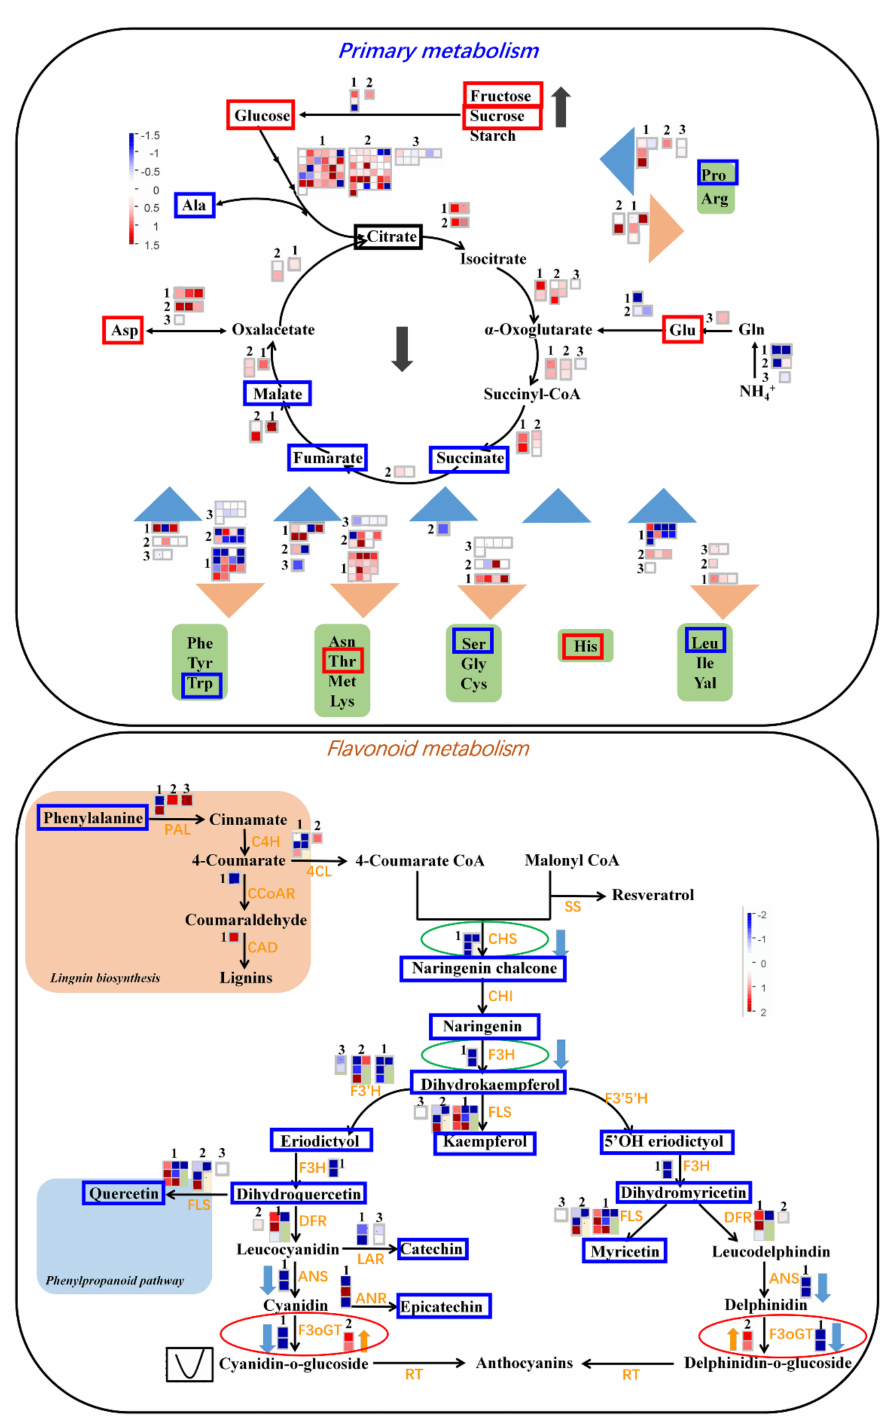
Figure 9. Metabolomic variations and transcriptional regulations during apple development: The red or blue boxes around each metabolite indicated that the metabolite increased or decreased its levels during fruit development. Each square represented the di ff erentially expressed genes (DEGs) involved in the corresponding pathways based on Mapman bins. The square color indicated the fold change of the DEGs (red means up-regulated and blue is down-regulated). The numbers “1”, “2” and “3” respectively represented the DEGs among PS1 versus (vs.) PS2, PS2 vs. PS3 and PS3 vs. PS4. The red and blue triangles in primary metabolism represented the synthesis and catalyzation of the amino acids, respectively. PS1, 2, 3 and 4 represent four fruit development stages: 27, 84, 125 and 165 Days After Anthesis (DAA),